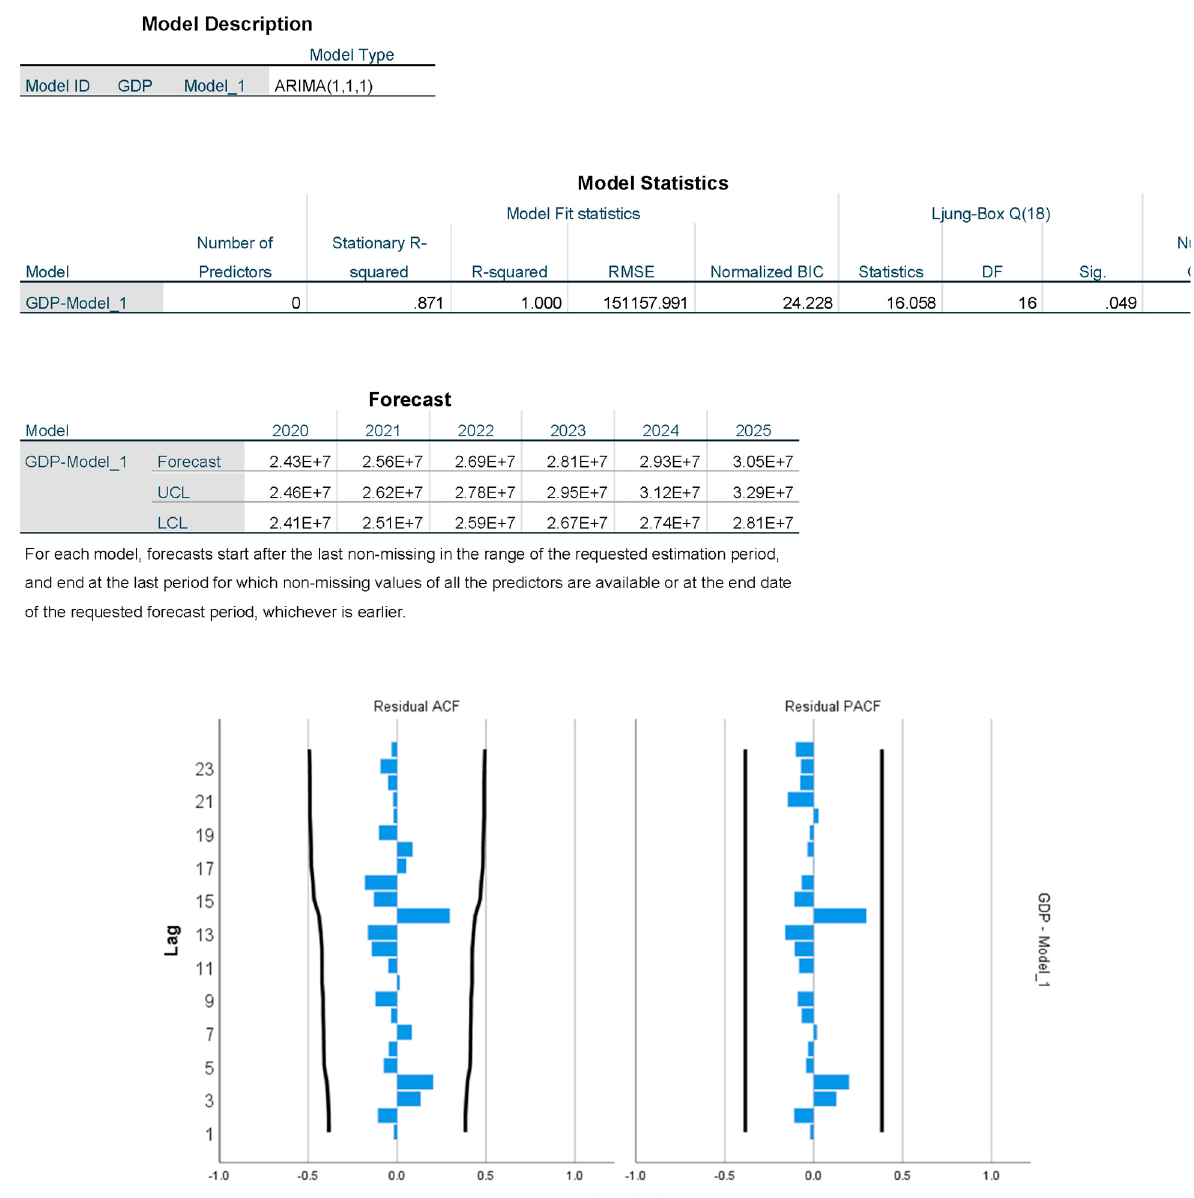
Figure A9. Model (5) Forecast in GDP.